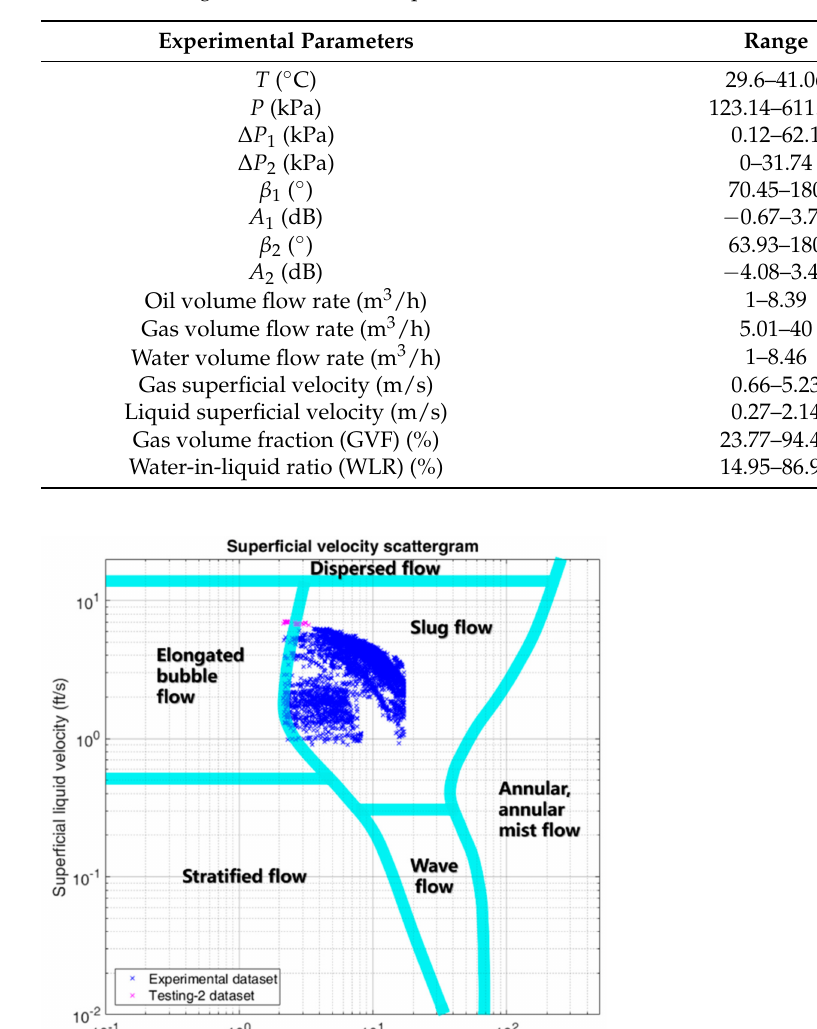
Table 2. Working conditions of the experiments.